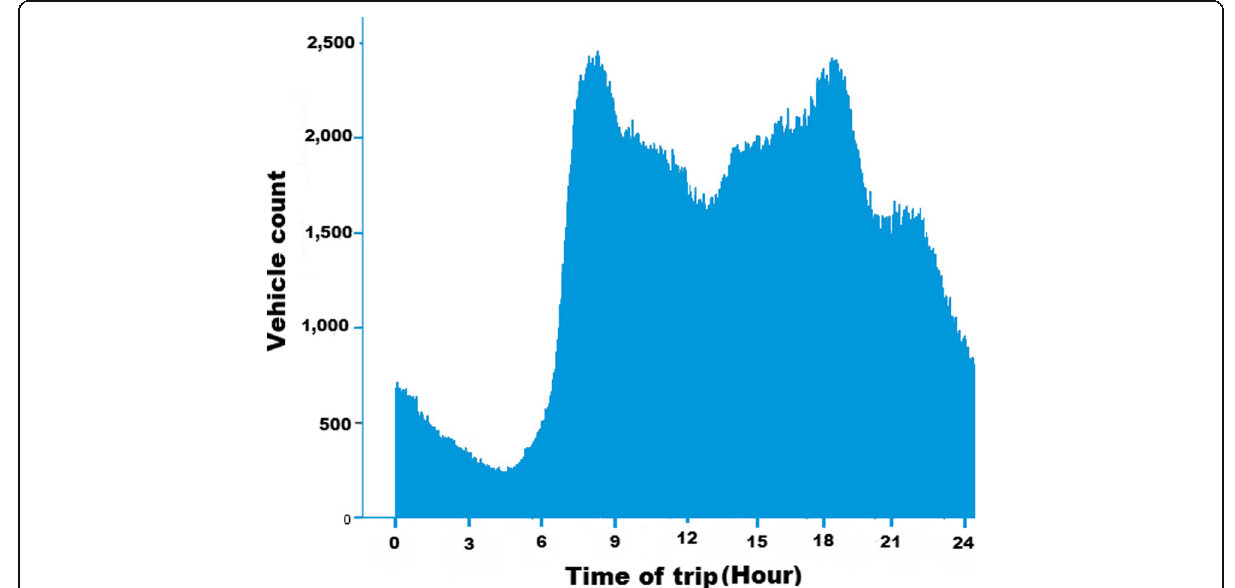
Fig. 1 Histogram of 24-h vehicle counts for May